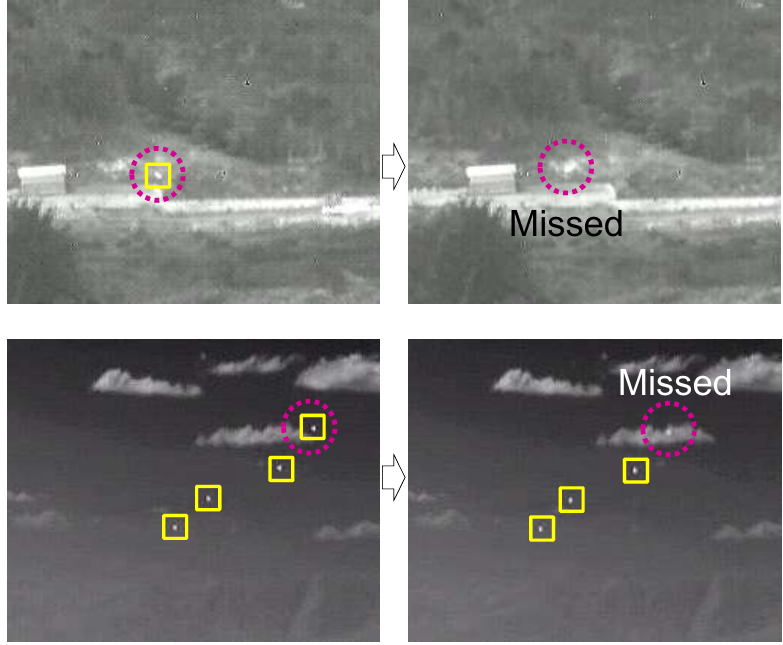
Figure 7. Limitation of the spatial filter (M-MSF)-based small target detection